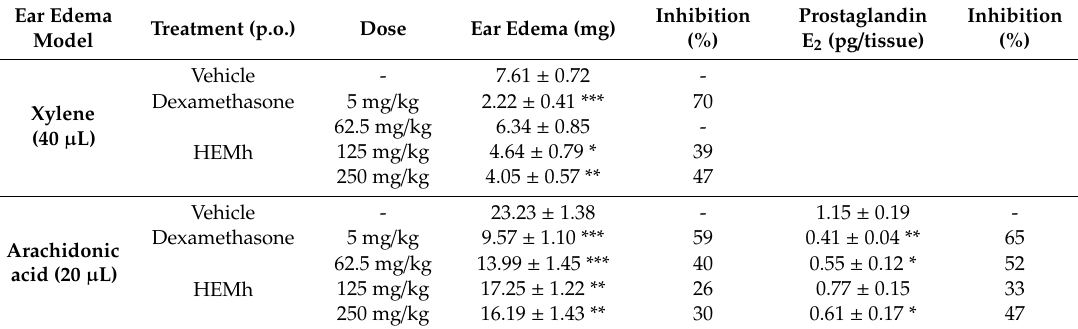
Table 3. Evaluation of the anti-edematogenic activity of hydroalcoholic extract from the twigs of Machaerium hirtum (HEMh) in mice ear edema induced by xylene or arachidonic acid. Ear Edema